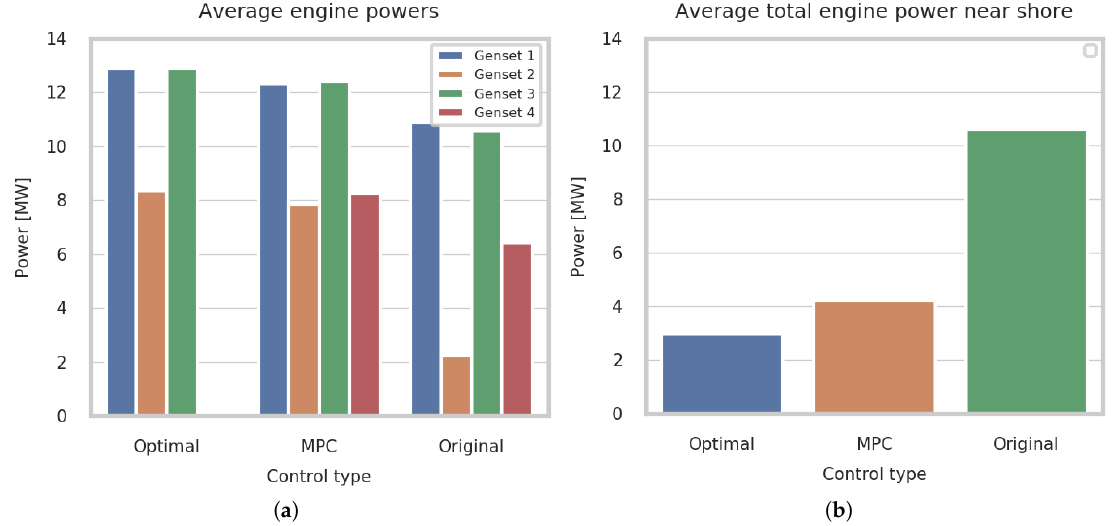
Figure 9. Average generating set powers in Mediterranean operation under different control strategies ( a ) and average total generating set power near shore under different control strategies ( b